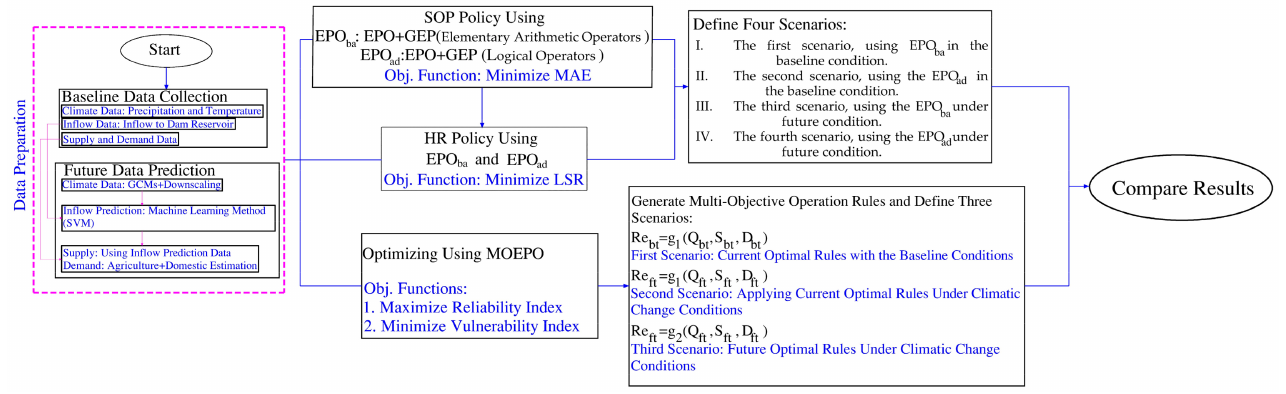
Figure 3. Flowchart of the research